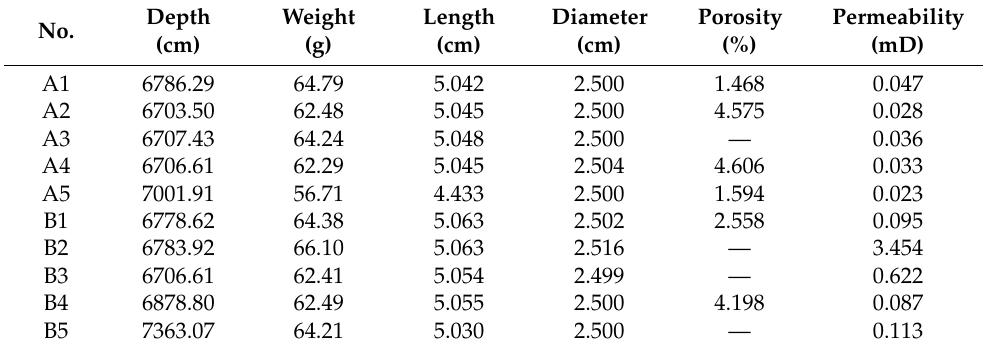
Figure 1. The rock samples drilled from the target formation. Table 1. The parameter values of rock samples.